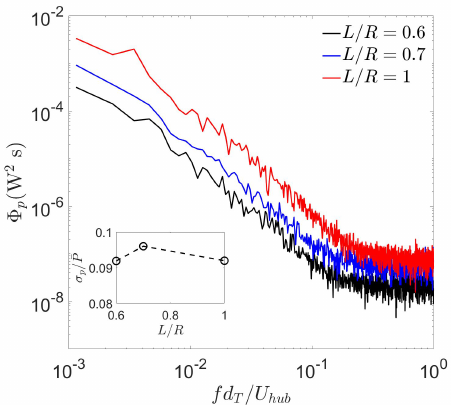
Figure 13. Power output spectra Φ p of turbines with various blade length ratios. The subplot shows the standard deviation of power